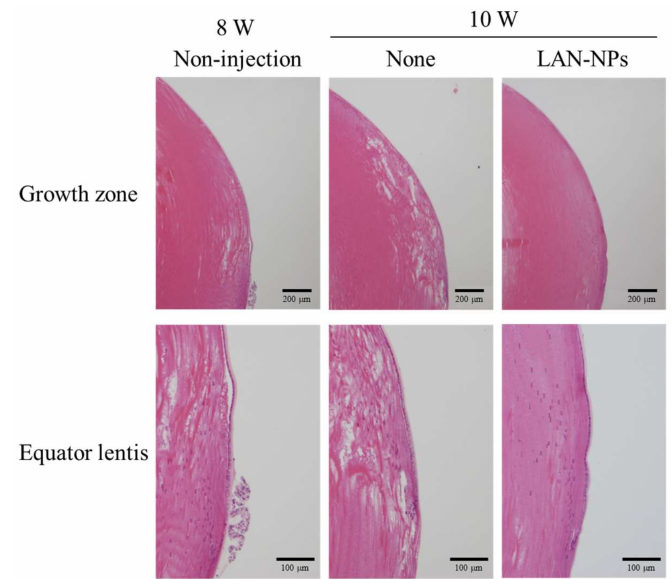
Figure 4. Changes in the lens structure of the growth zone and equator lentis in 8- and 10-week-old SCR-N intravitreously injected or not injected with LAN-NPs. Eight week-old SCR-N were intravitreously injected with LAN-NPs for 2 weeks (once per 2 days). Non-injection, non-injected SCR-N aged 8 weeks; None, non-injected SCR-N aged 10 weeks; LAN-NPs, LAN-NP injected SCR-N aged 10 weeks. Slight collapse of the lens structure was observed in the SCR-N aged 8 and 10 weeks. On the other hand, the intravitreal injection of LAN-NPs reversed spatial and structural collapse in the lenses of SCR-N.